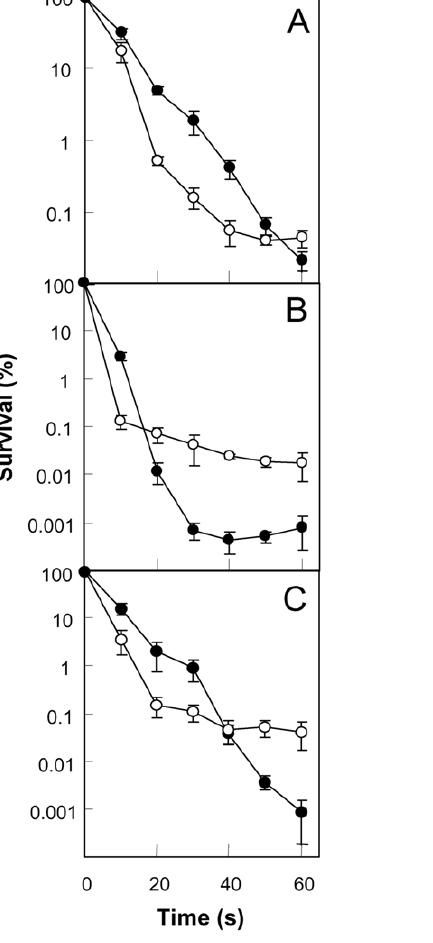
Figure 3. Effect of ndoA deficiency on bacterial survival after treatment with UV irradiation. Overnight cultures of B. subtilis were diluted with LB medium, 10- m l aliquots were spotted on LB agar plates, and spots were allowed to dry. The plates were exposed to UV irradiation (254 nm) at various intensities for the indicated times, and they were incubated overnight at 37 u C. Wild-type strain (BD630, filled circles) and its D ndoA mutant (3169, open circles) received low (0.14 mW/cm 2 , panel A), high (0.4 mW/cm 2 , panel B), or moderate exposure (0.2 mW/cm 2 , panel C). Error bars indicate standard deviation; similar results were obtained in replicate experiments.